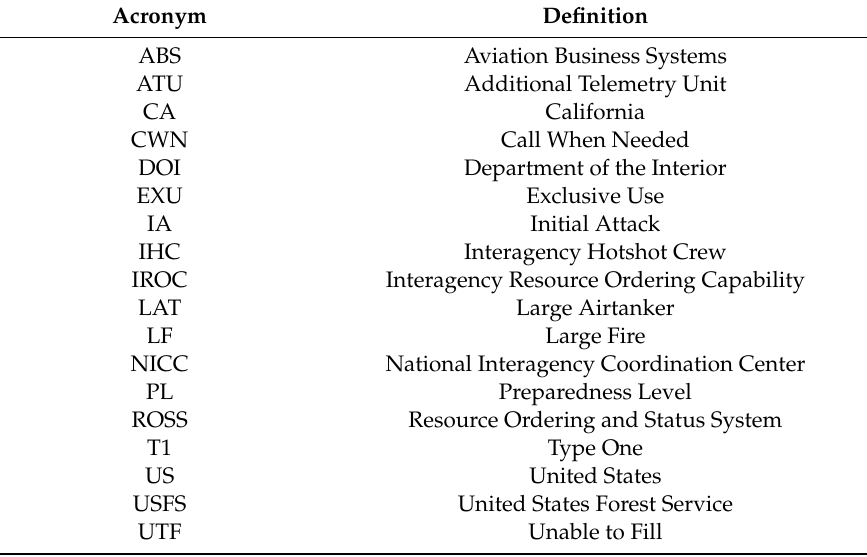
Table A1. A list of acronyms used in this